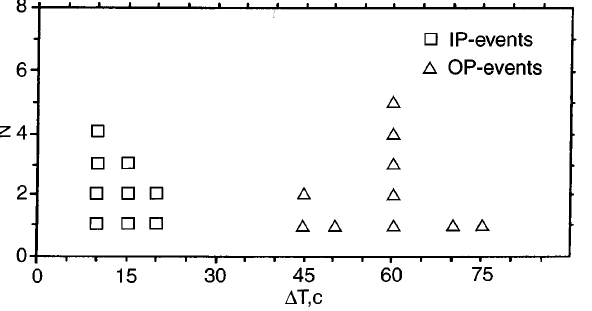
Fig. 7. Plot of the number of events versus the event duration. IP signifies the event of simultaneous enhancement of the intensity in the arcs, OP signifies the event of opposite behaviour of the arc intensity, (cid:68) T is the duration